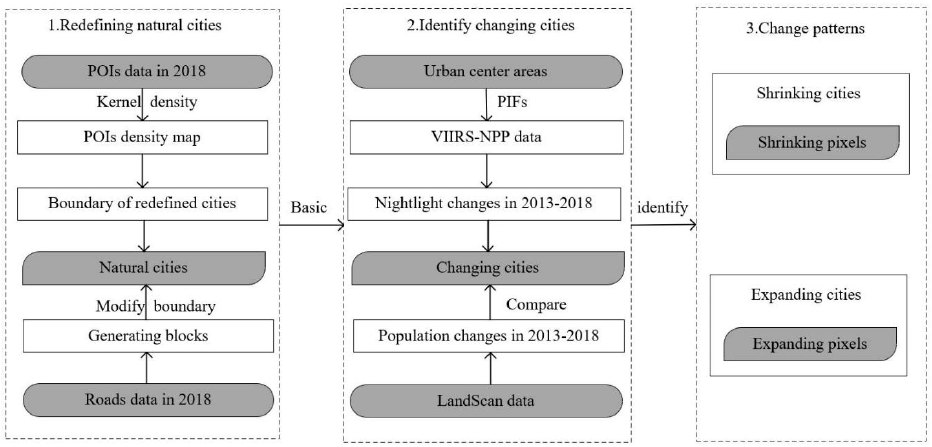
Figure 2. Analytical framework.